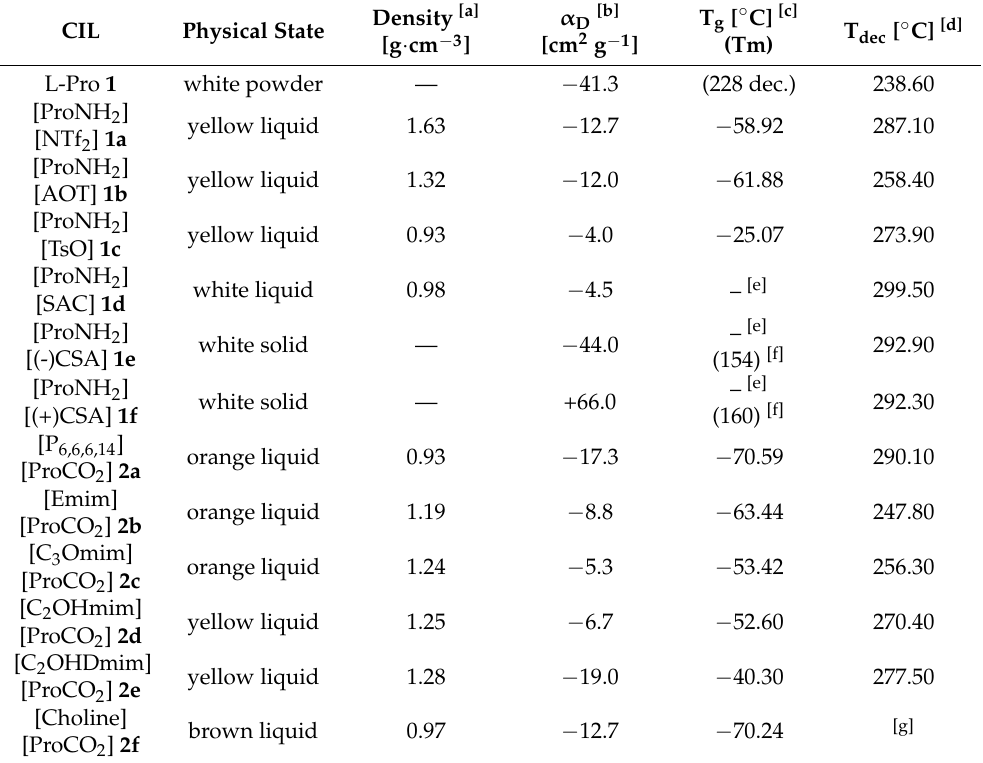
Table 1. Some physical and thermal properties of new, synthesized salts based on L-proline scaffold. CIL Physical